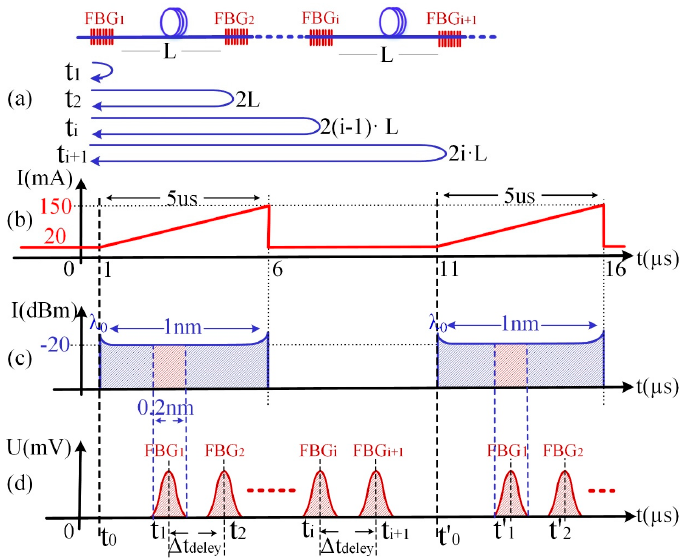
Figure 2. Principle of FBG distinction and demodulation. ( a ) The arrangement of FBGs and the received times of each reflection peaks; ( b ) Driving signal of the DFB laser; ( c ) The output of the DFB laser; ( d ) The reflected waveform of FBGs received by the photodetector (PD).